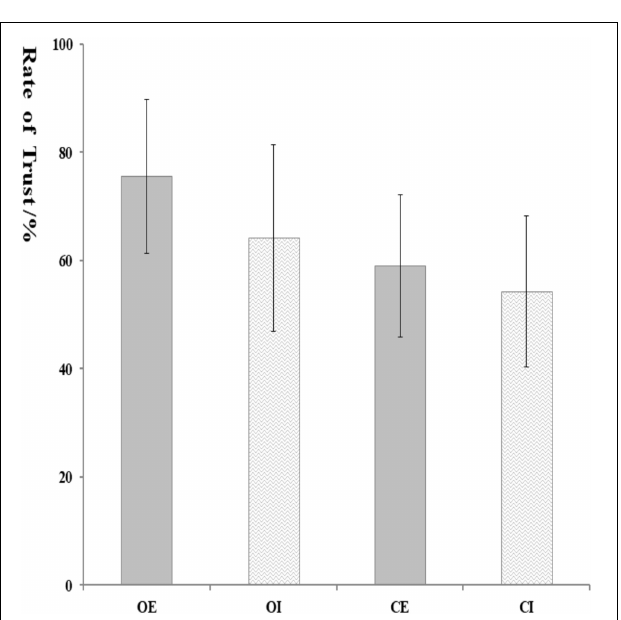
FIGURE 3 | The reaction time of trust decision. Error bars represent the standard